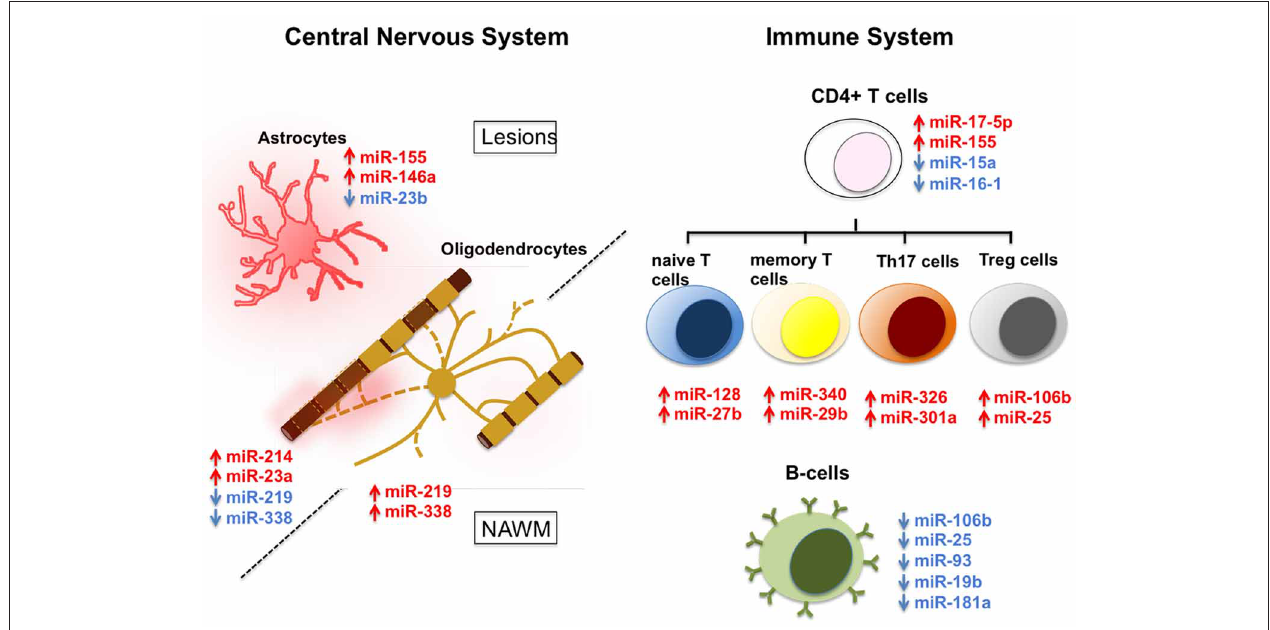
FIGURE 1 | MicroRNA (miRNA) dysregulation in CNS lesions and immune cells of MS patients. miRNAs that are up- (red) and down-regulated (blue) in CNS lesions, NAWM, or immune system of MS patients have been assigned to specific cell types. Dysregulation is associated with astrocytes and oligodendrocytes in the CNS and naïve